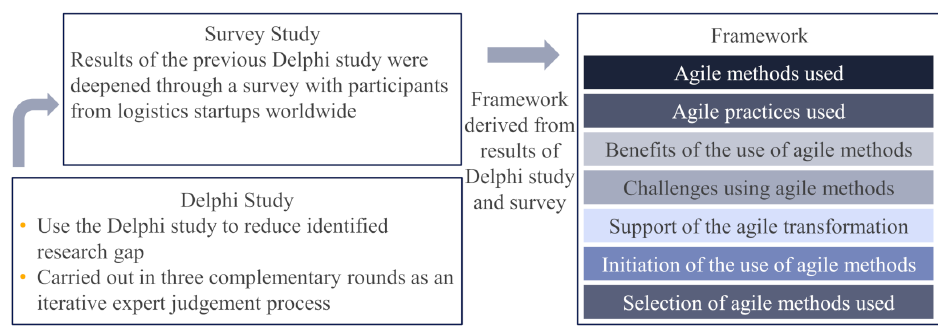
Figure 1. Development of the framework.